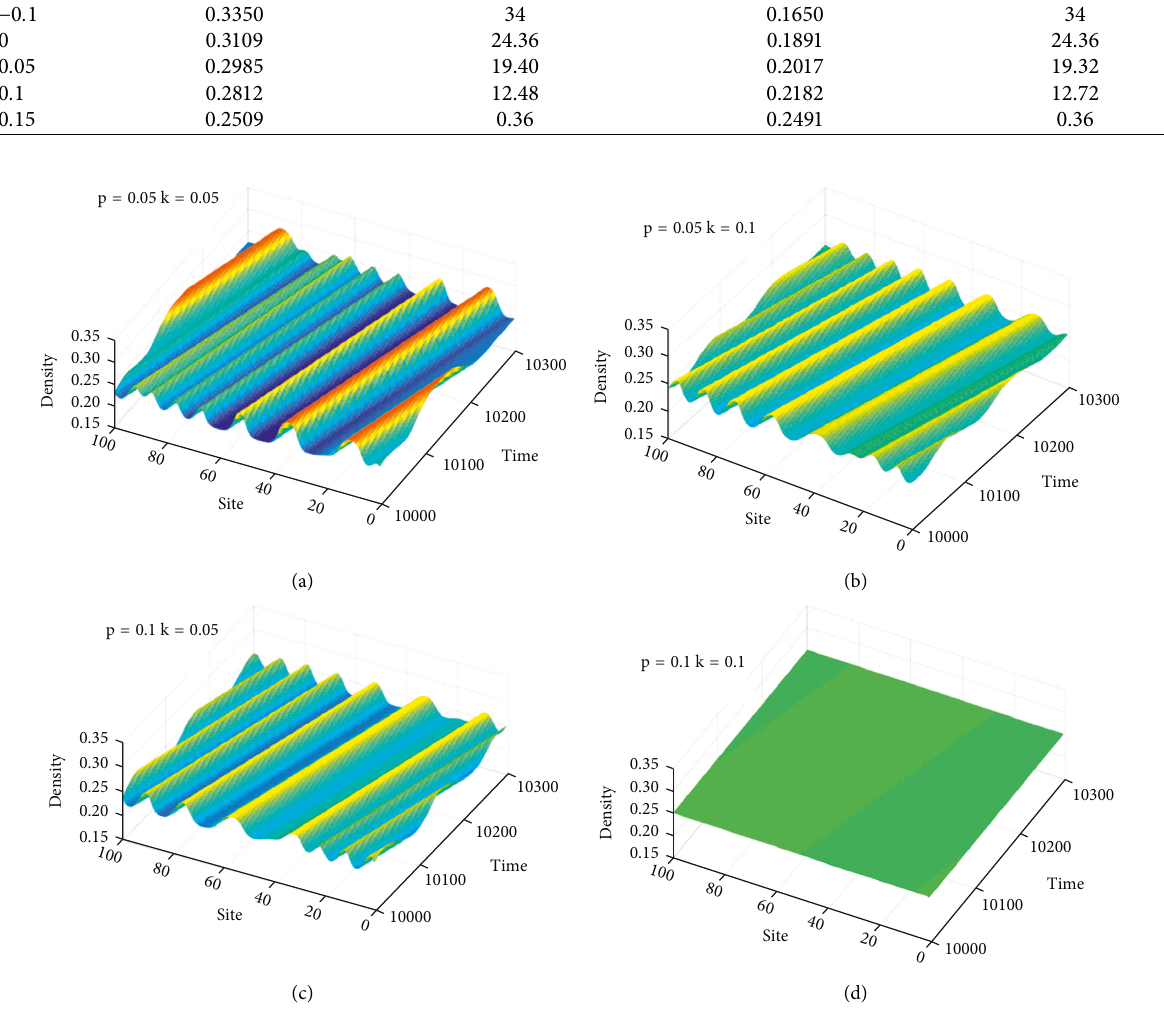
Figure 4: Spatiotemporal evolution of the density wave with time under the action of different parameters. (a) p � 0.05, k � 0.05. (b) p � 0.05, k � 0.1. (c) p � 0.1, k � 0.05. (d) p � 0, k �